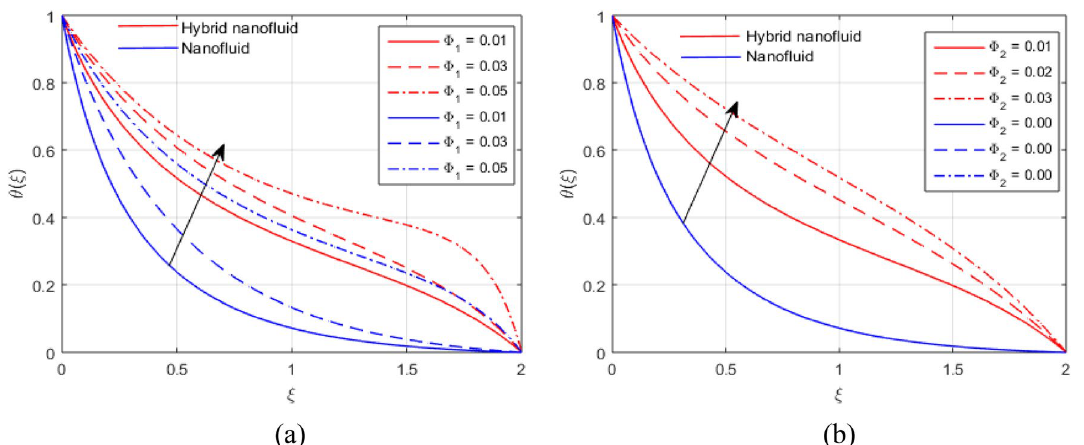
Figure 12. ( a , b ) Effect of (cid:31) 1 and (cid:31) 2 and θ(ξ) .